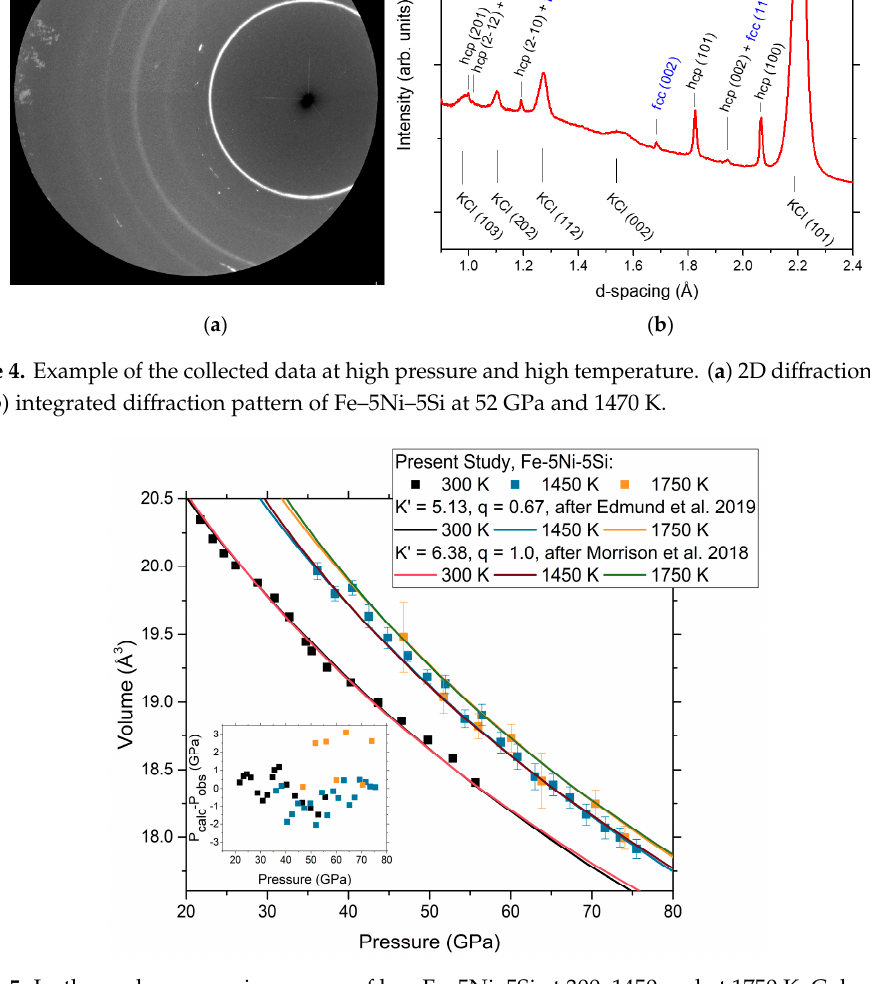
Figure 5. Isothermal compression curves of hcp Fe–5Ni–5Si at 300, 1450 and at 1750 K. Color-coded solid lines are the thermal equation of state fit to the experimental data, with the values of K’ and q fixed according to either Edmund et al., 2019 [23] or Morrison et al., 2018 [8]—cases 1 and 3, specifically. Inset: residuals in pressure for the present dataset (colors correspond to the respective isotherms of the main figure). See main text for more details.